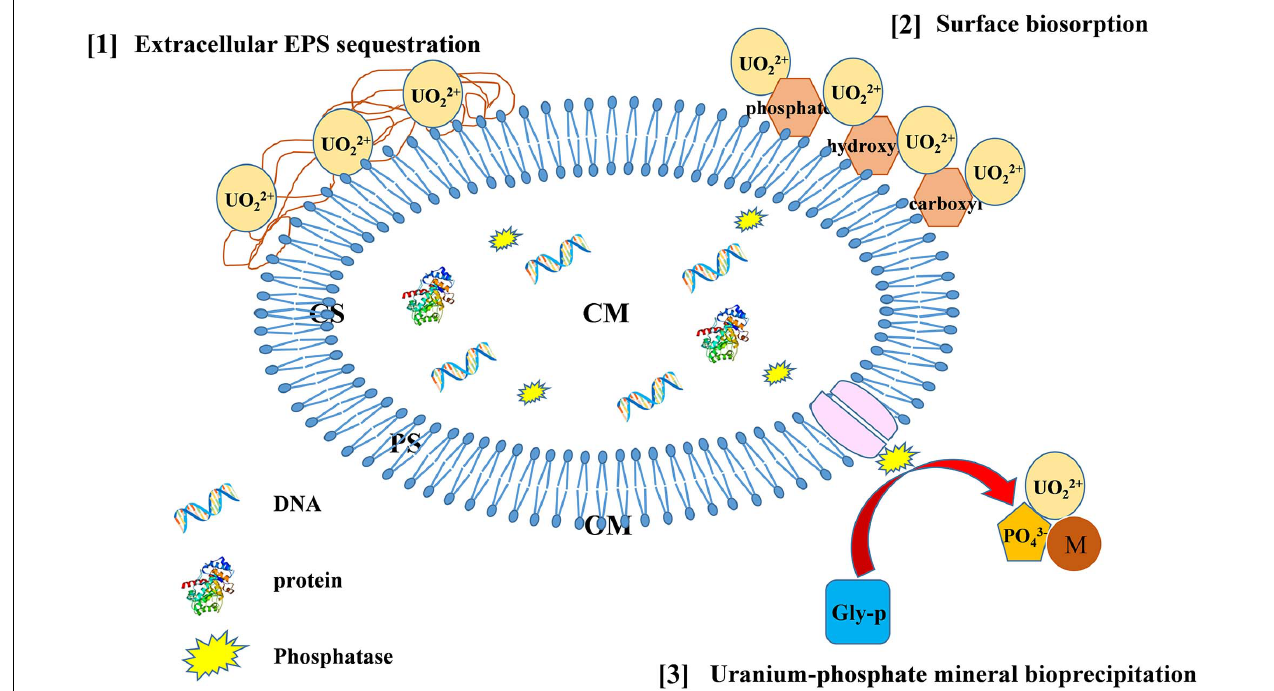
FIGURE 7 | The possible mechanisms of U immobilization by Bacillus spp. (CS, cytoplasm; CM, cytomembrane; PS, periplasm; OM, outer membrane).